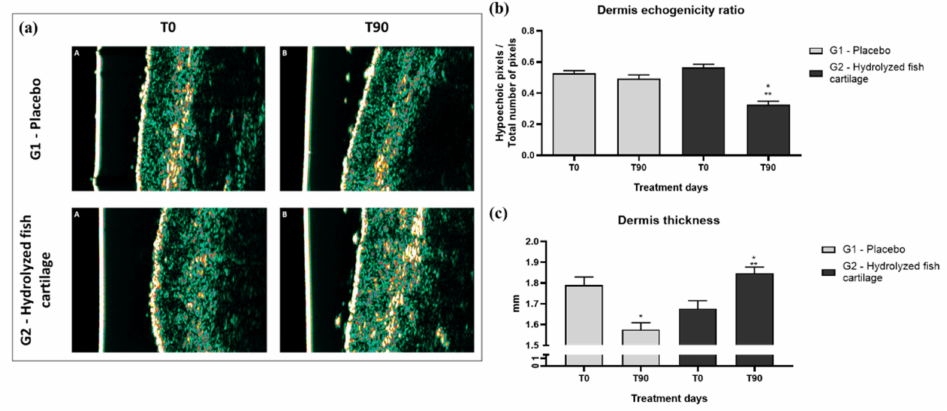
Figure 2. ( a ) Representative 20-MHz ultrasound images of dermis echogenicity before (T0) and after 90 days (T90) of supplementation with hydrolyzed fish cartilage or placebo. Echogenicity color scale: White > yellow > red > green > blue > black. ( b ) Dermis echogenicity ratio (hypoechogenic pixels/total number of pixels) before (T0) and after 90 days (T90) of supplementation with hydrolyzed fish cartilage or placebo. ( c ) Dermis thickness before (T0) and after 90 days (T90) of supplementation with hydrolyzed fish cartilage or placebo. * Significant differences when compared to baseline values—T0 ( p < 0.05). ** Significant differences when compared to the placebo